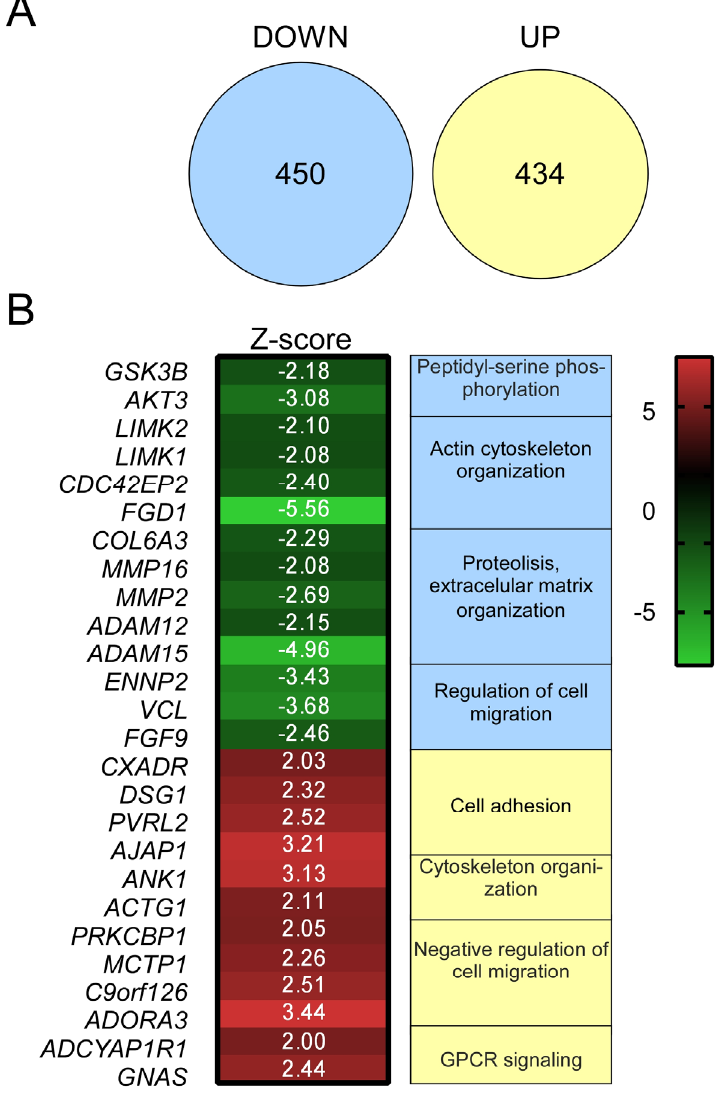
Figure 7. Regulation of gene expression patterns by A2BR activation with BAY-606583 in SKOV-3 cells was analyzed by cDNA microarrays. SKOV-3 cell cultures were stimulated with 10 µ M BAY-606583 for 16 h and total RNA was isolated; a pool of five independent cultures was hybridized against a library of 30 K genes of the complete human genome. ( A ) BAY-606583 induced broad changes in gene expression; the Venn diagram represents the set of transcripts up- or down-regulated by the agonist. ( B ) A heat-map representation of the Z-score of outstanding transcripts up- or down-regulated by BAY-606583. The cellular process determined by GO analysis is